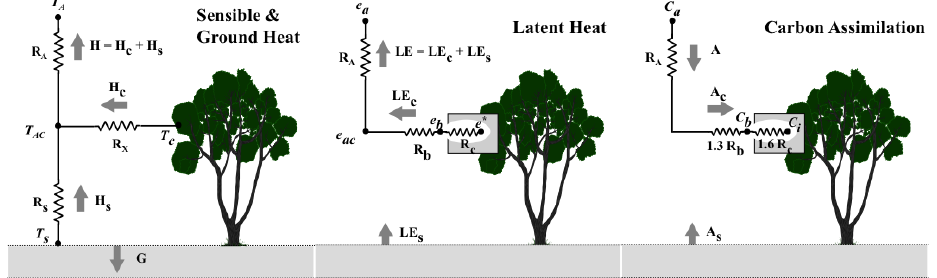
Figure 1. Schematic illustrating the LUE-based canopy resistance method, diagramming its role within TSEB framework for computing coupled carbon, water, and energy